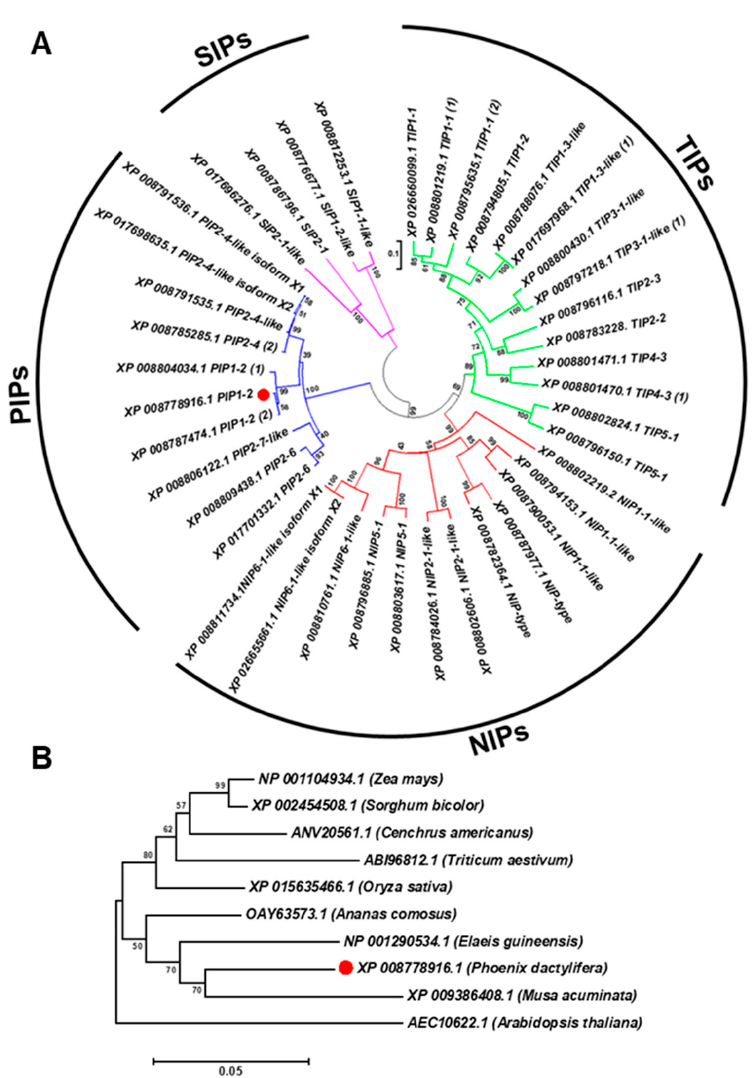
Figure 1. PdPIP1;2 belongs to a large, conserved aquaporin family. The phylogenetic analysis of 40 date palm aquaporins ( A ) and the phylogenetic relationship between PdPIP1;2 isoforms (marked by red circle) and aquaporins of other plant species ( B ). The phylogenetic trees were constructed using the amino acid sequences and the neighbor-joining method. Bootstrap values on the nodes represent percentages of 1000 repetitions.